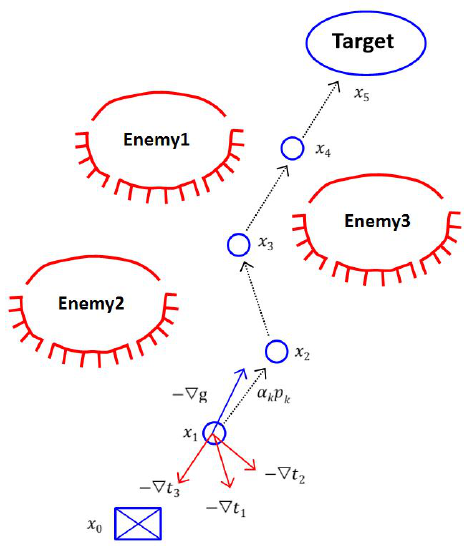
Figure 5. Sample conceptual diagram of a PFP